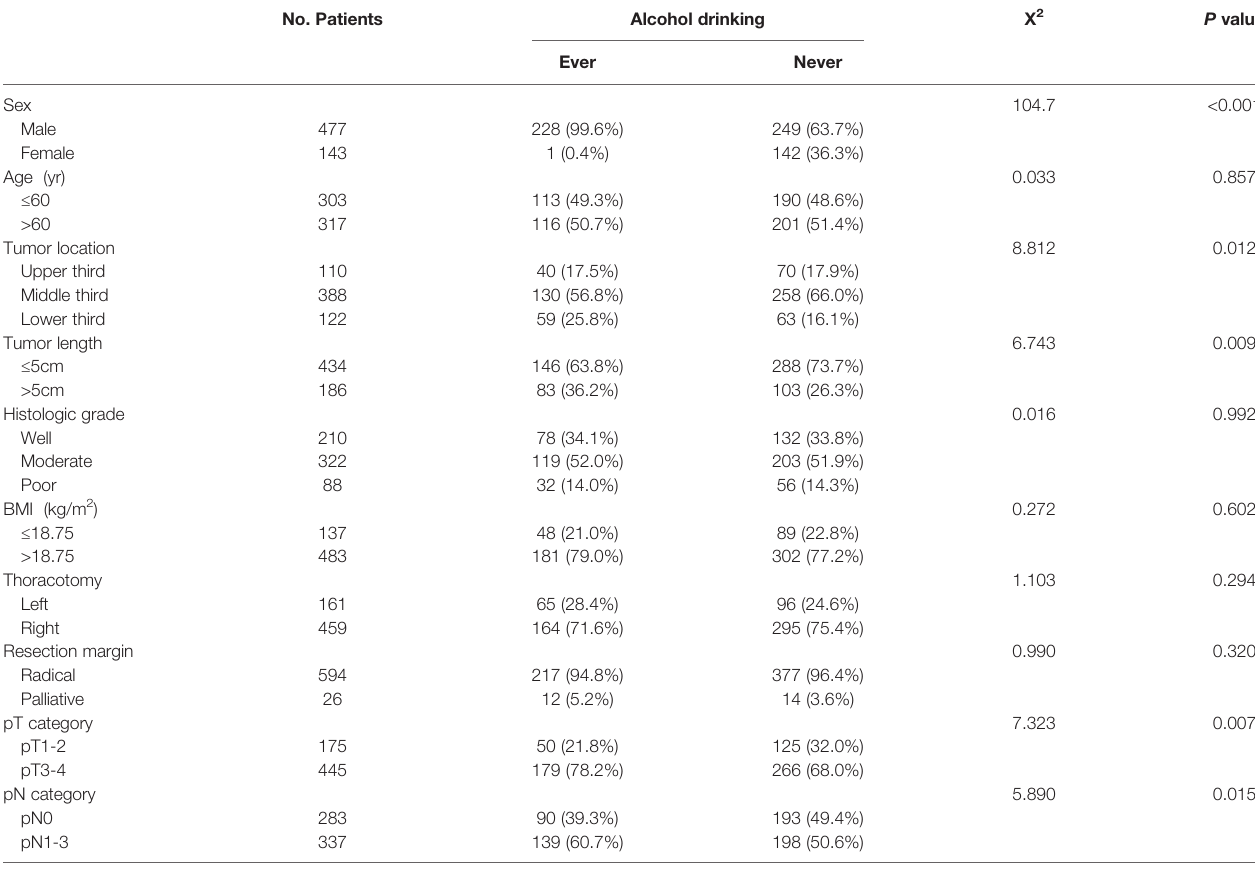
TABLE 1 | Correlation of alcohol drinking status with the clinicopathological